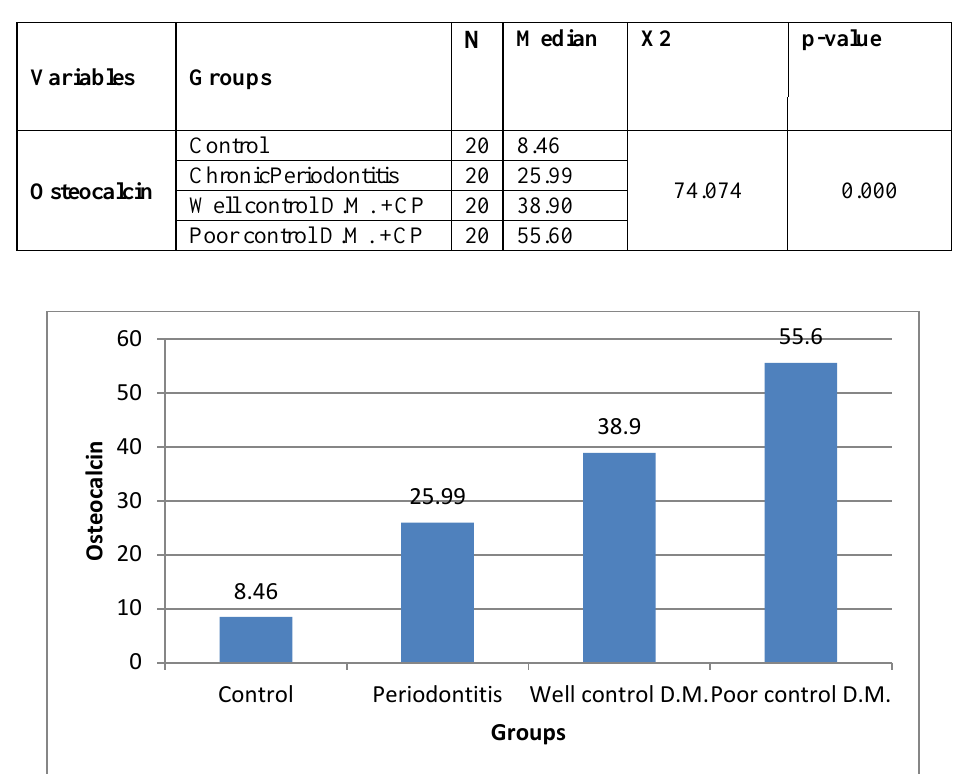
Table 3: Analytic statistics of Osteocalcin concentrations (ng/ml) for the study and control groups